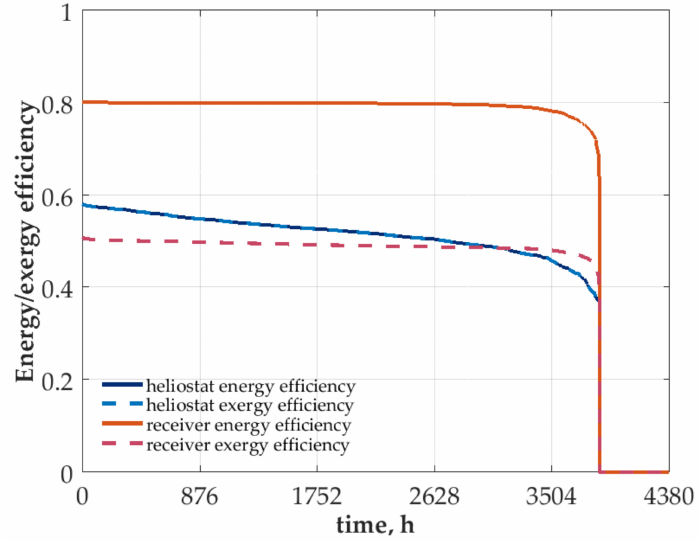
Figure 3. Annual load curve for the heliostat and receiver efficiencies.